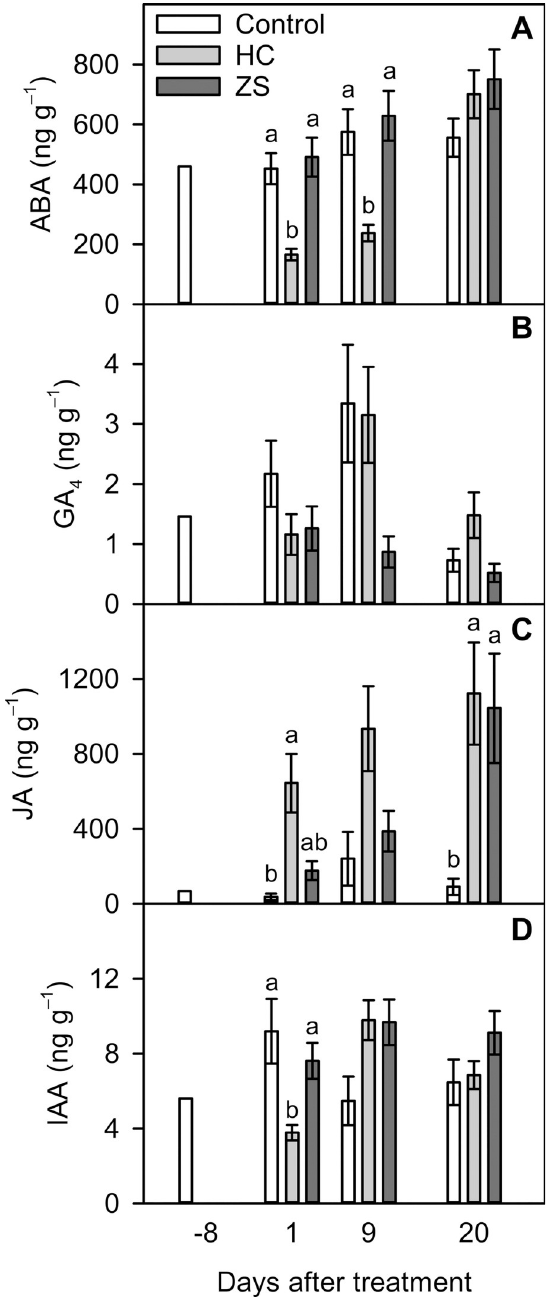
Fig 4. Phytohormone dynamics in flower buds of ‘Emerald’ blueberry grown under inadequate chilling conditions as affected by hydrogen cyanamide (HC) and zinc sulfate (ZS) in the 2018–2019 season (Expt. 1). (A) Abscisic acid (ABA). (B) Gibberellin 4 (GA 4 ). (C) Jasmonic acid (JA). (D) Indole-3-acetic acid (IAA). Treatments are as described in Fig 1. Pre-treatment samples (8 days before treatment) were pooled as a composite control sample. Means (n = 3–4) with the same or no letter within each measurement day are not significantly different (Tukey–Kramer test, P < 0.05).